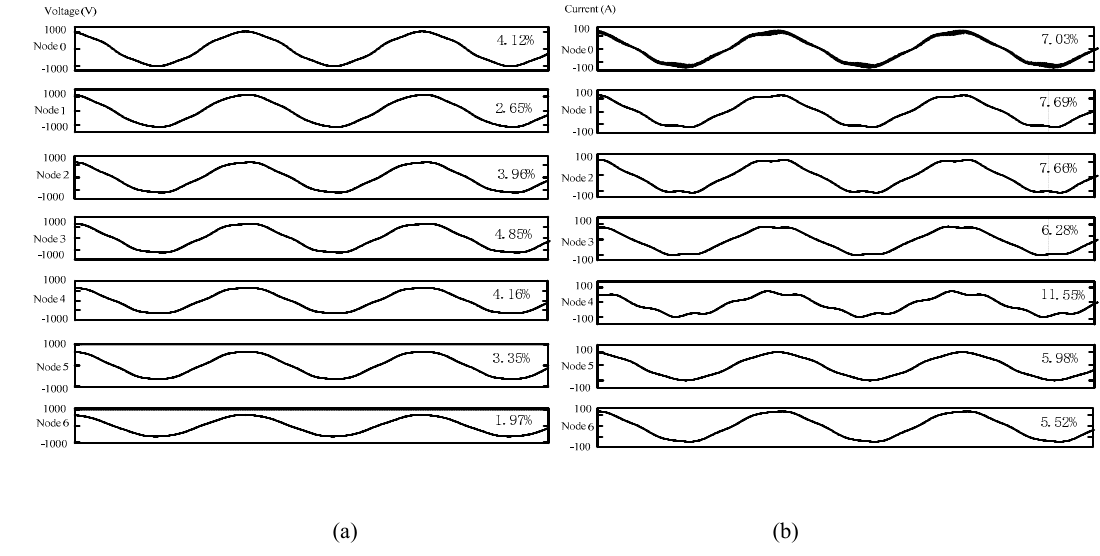
Figure 13. Voltage and current waveform with traditional R-APF: ( a ) voltage, and ( b ) current .